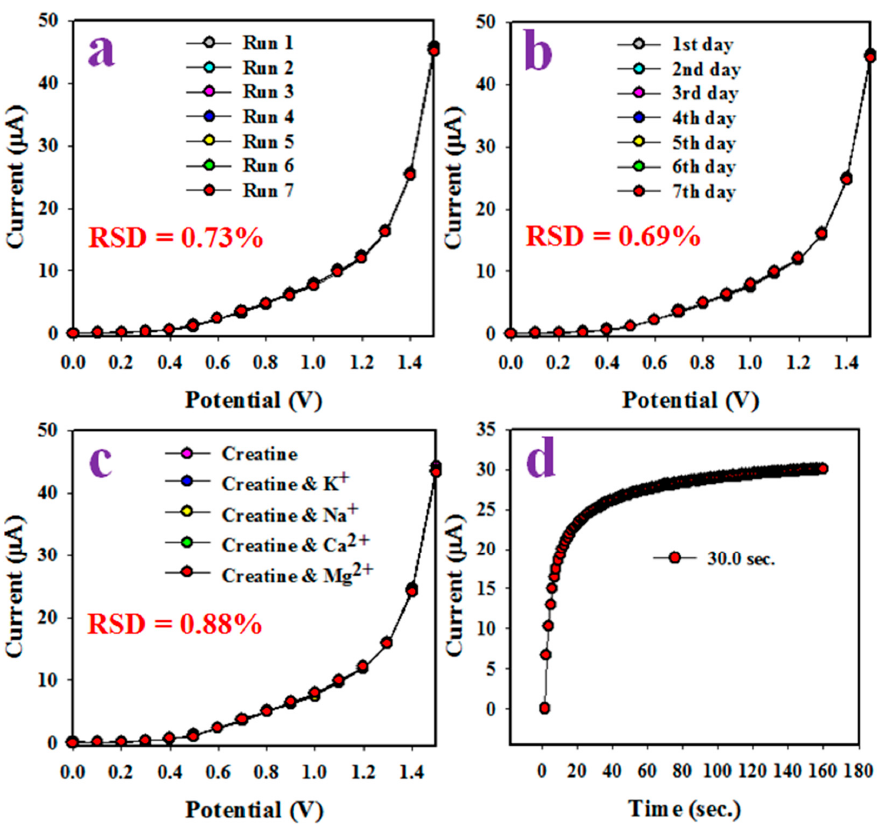
Figure 5. Optimization of the creatinine sensor. ( a ) Reducibility of the CA sensor, ( b ) validity of CA sensor around 7 days, ( c ) interference effect estimation in the presence of electrolytes and ( d ) response time.